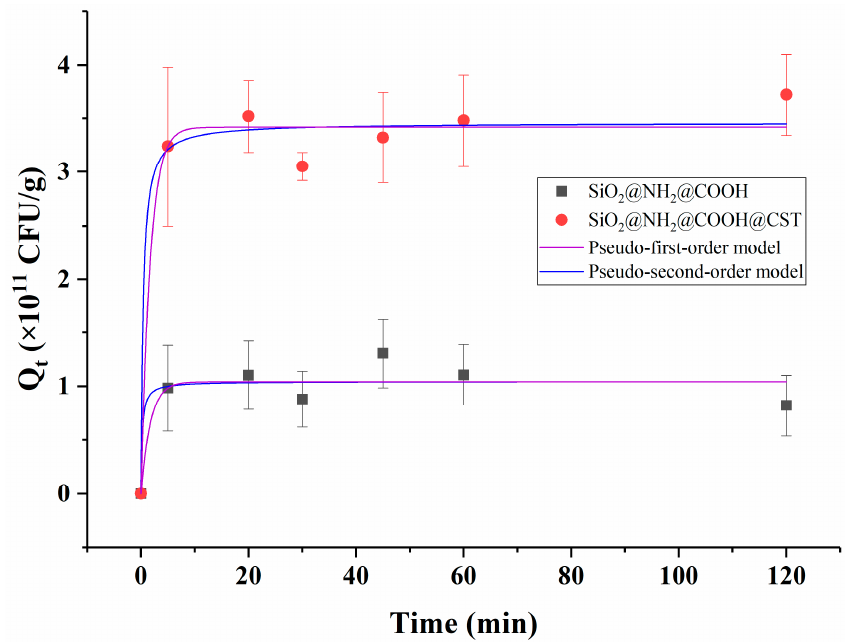
Figure 5. Pseudo-first-order models and pseudo-second-order models of E . coli